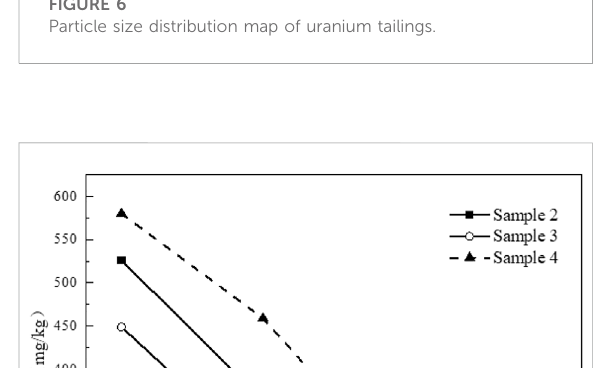
FIGURE 6 Particle size distribution map of uranium tailings.